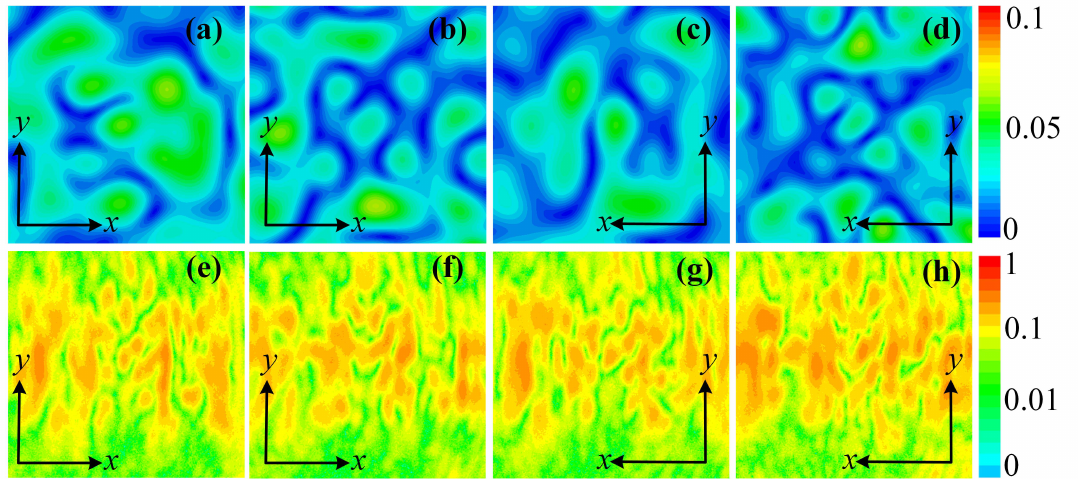
Figure 11. Simulated co-polarized electric fields amplitude distributions for different OAM orders: ( a ) l = + 1. ( b ) l = + 2. ( c ) l = − 1. ( d ) l = − 2. Measured co-polarized electric fields amplitude distributions for different OAM orders: ( e ) l = + 1. ( f ) l = + 2. ( g ) l = − 1. ( h ) l = −